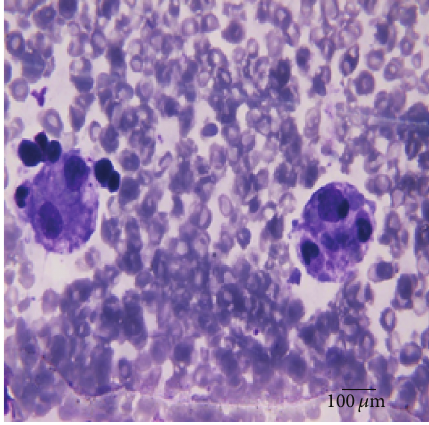
Figure 1: Image showing two macrophages with hemophagocytosis in bone marrow aspiration smear (magnification ×